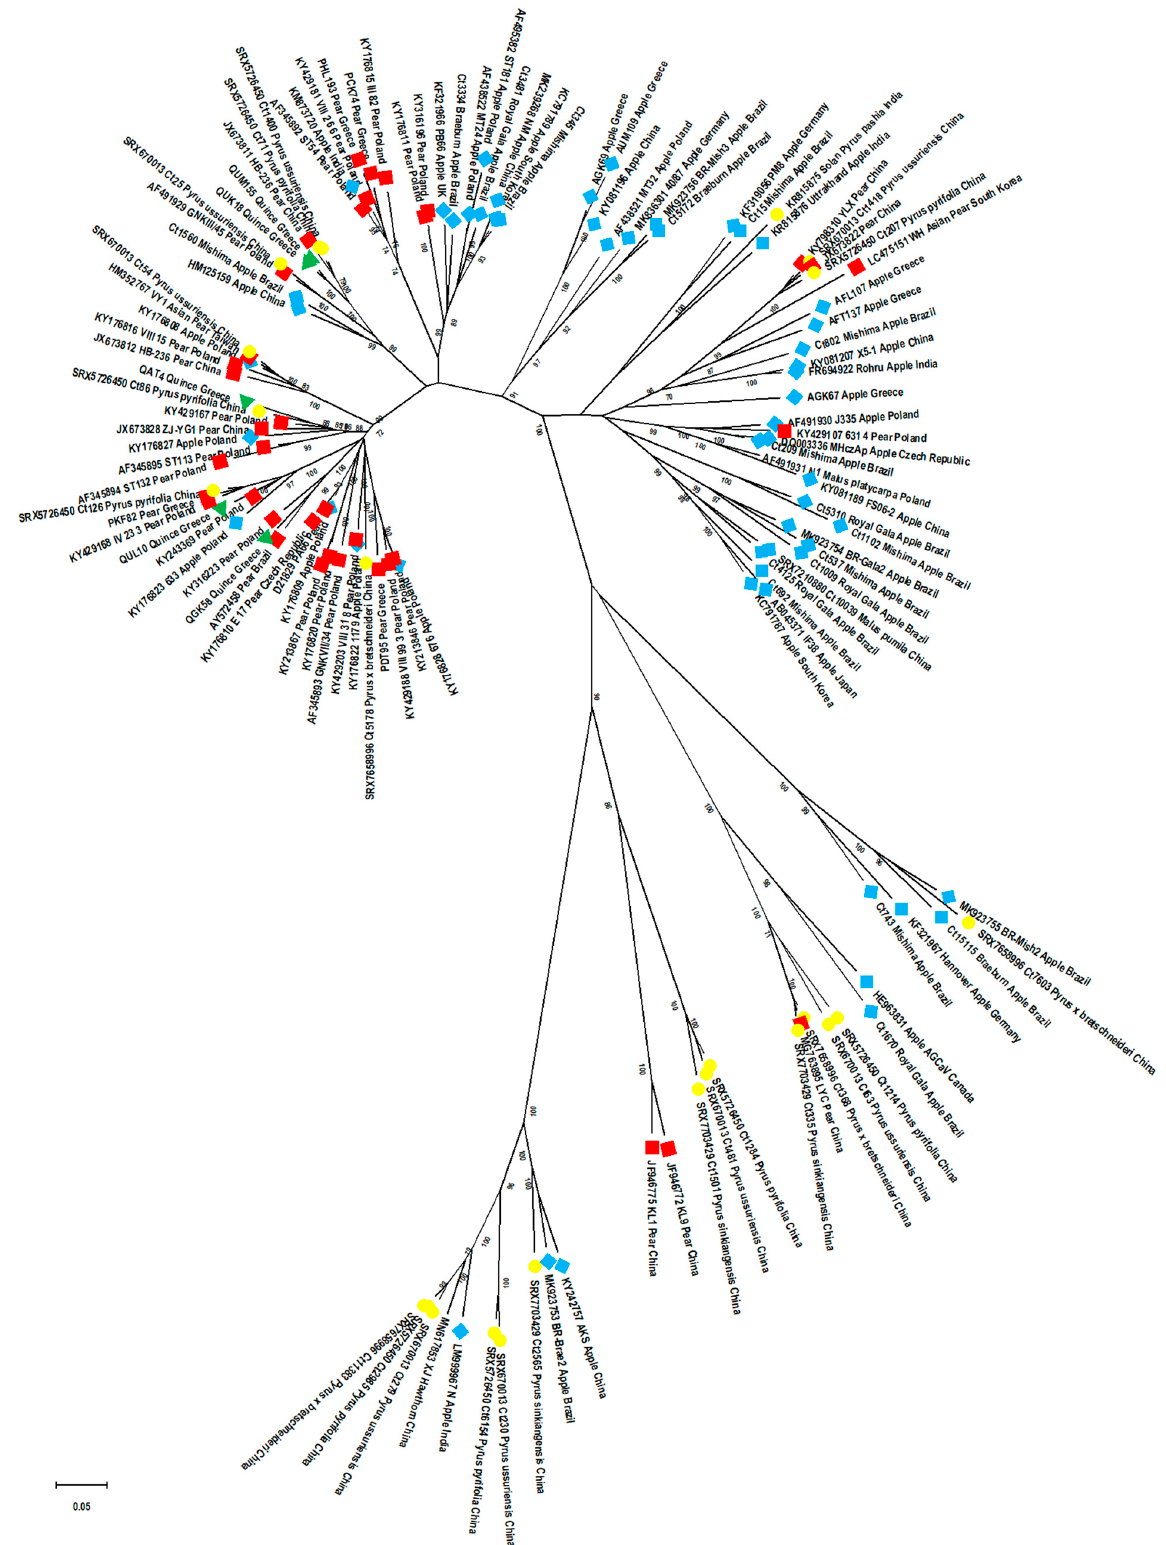
Figure 3. The ML phylogenetic tree (radical shape) of the CP nucleotide sequences, generated using MEGA X. The isolates are indicated by their accession number or isolate name, host and country of origin. The isolates are color-coded based on the host of origin; green: quince, light blue: apple, red: pear, yellow: botanical pears. Branches with <70% bootstraps were collapsed. The scale bars represent a genetic distance of 0.05. The classical shape tree can be examined in Figure S4.